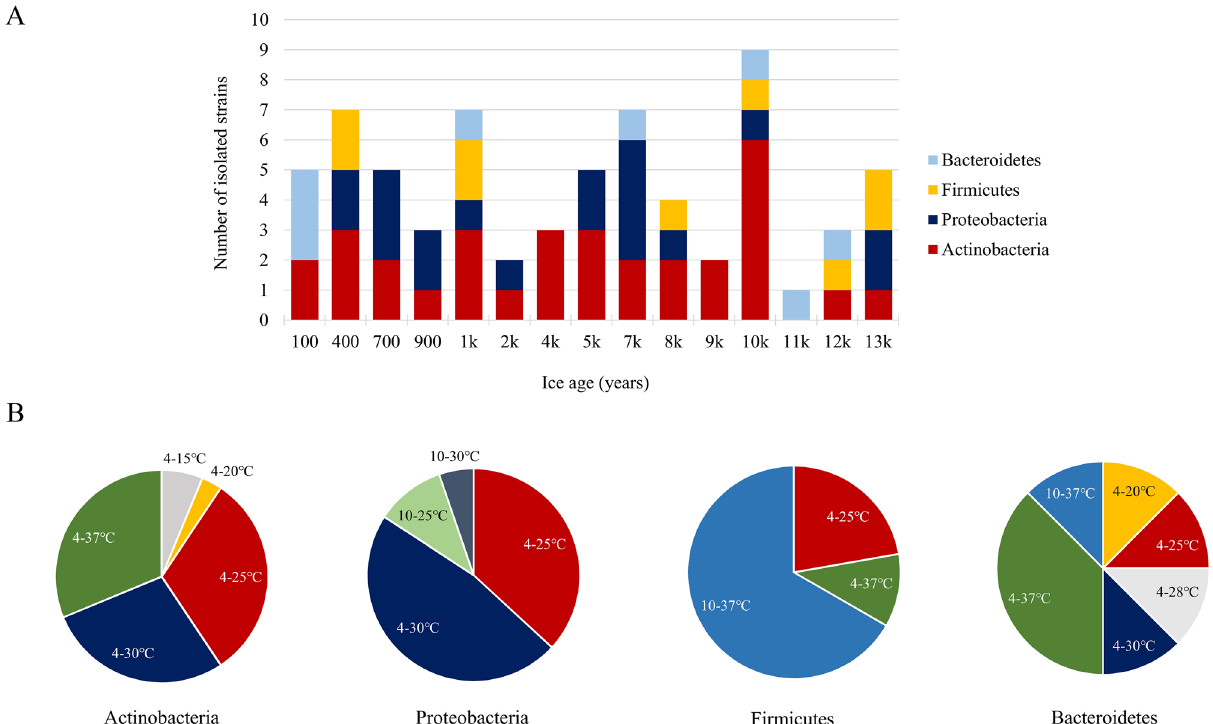
Figure 1. Phyla and growth temperature distribution of cave ice bacterial isolates along Scarisoara ice core. ( A ) Number of phyla in ice core strata up to 13,000 years BP; ( B ) Growth temperature interval distribution of cave isolates belonging to Actinobacteria, Proteobacteria, Firmicutes and Bacteroidetes